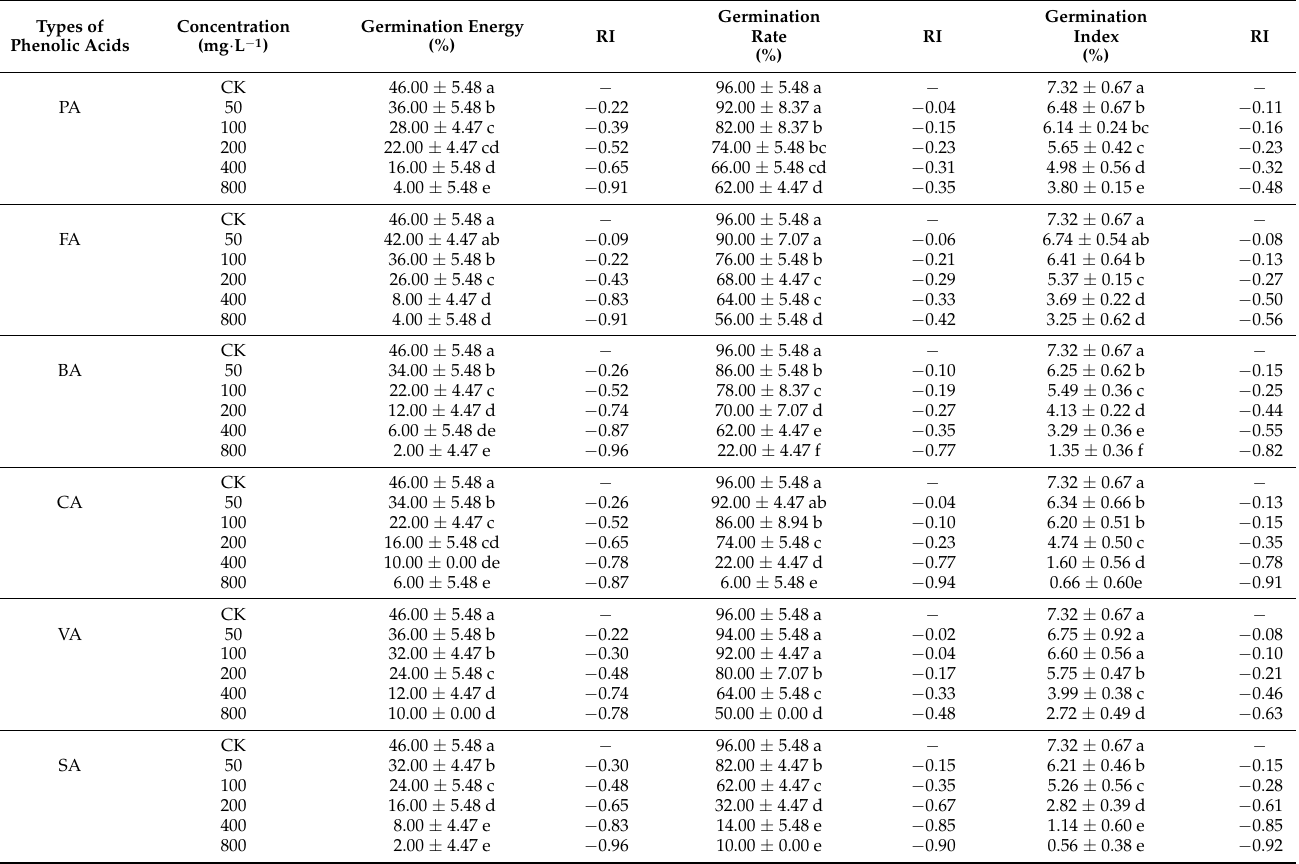
Table 1. Effect of the exogenous addition of various phenolic acids on the germination of faba bean seeds.